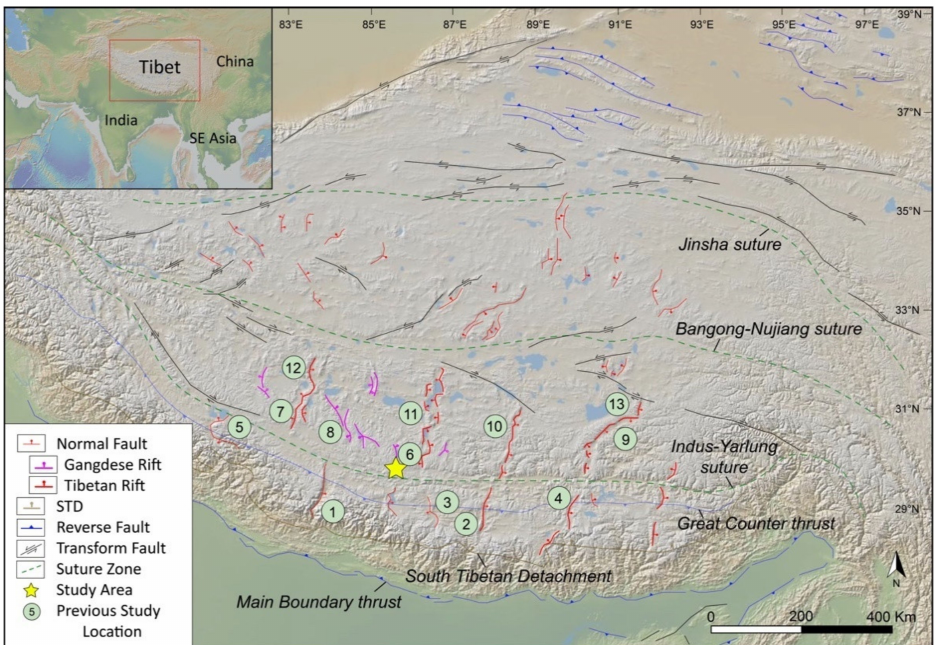
Figure 1. Topographic map of the Tibetan Plateau highlighting major deformational structures and suture zones adapted from Taylor and Yin (2009) [35]. The basemap is a global multi-resolution topography (GRMT) synthesis digital elevation model rendered in the GeoMapApp (geomapapp.org). Numbered green dots represent locations of previous studies investigating Miocene extension in central and southern Tibet, adapted from Sundell et al. (2013) [23]. Studies are labeled with numbers increasing from SSW to NNE (measured orthogonal to the Indus-Yarlung suture zone): 1. Thakkhola graben [36], 2. Arma Drime massif [37], 3. Kung Co graben [38], 4. Ringbung graben [39], 5. Gurla Mandhata dome